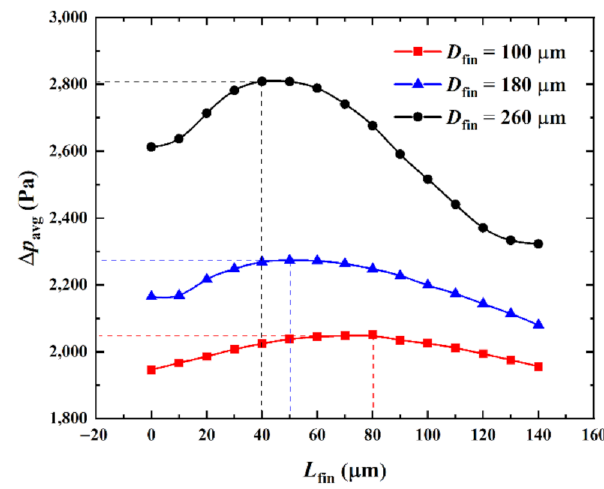
Figure 13. Effect of D fin on ∆ p avg versus L fin .